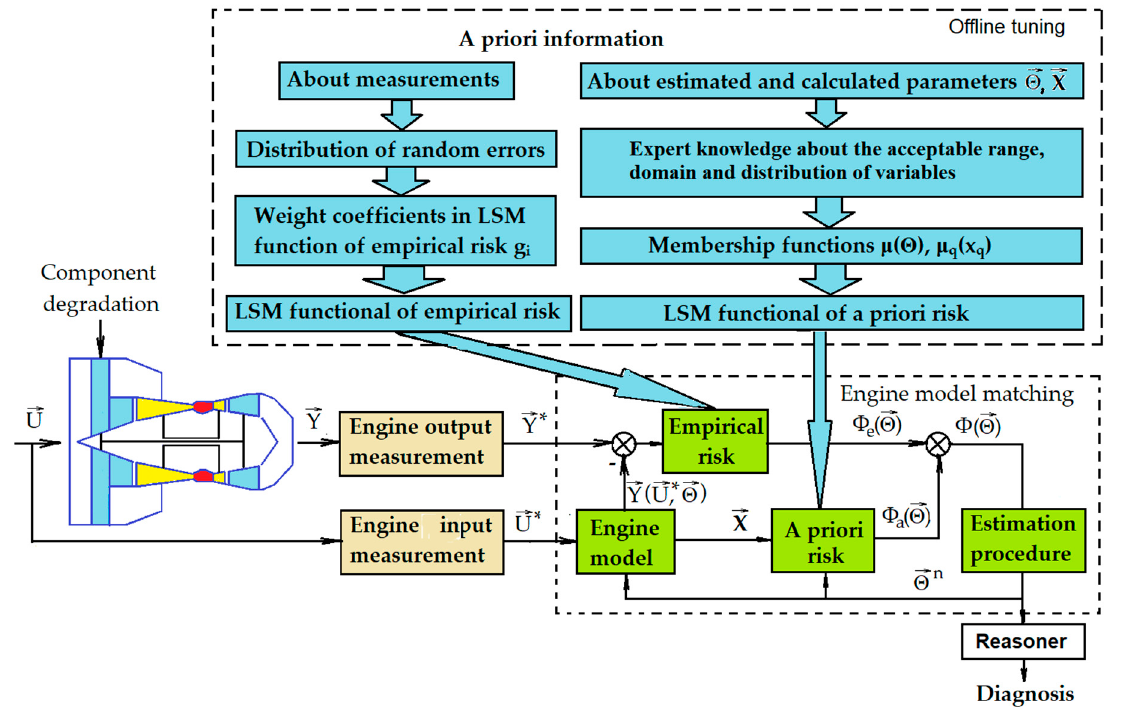
Figure 1. Regularized multi-criteria identification of gas-turbine model.